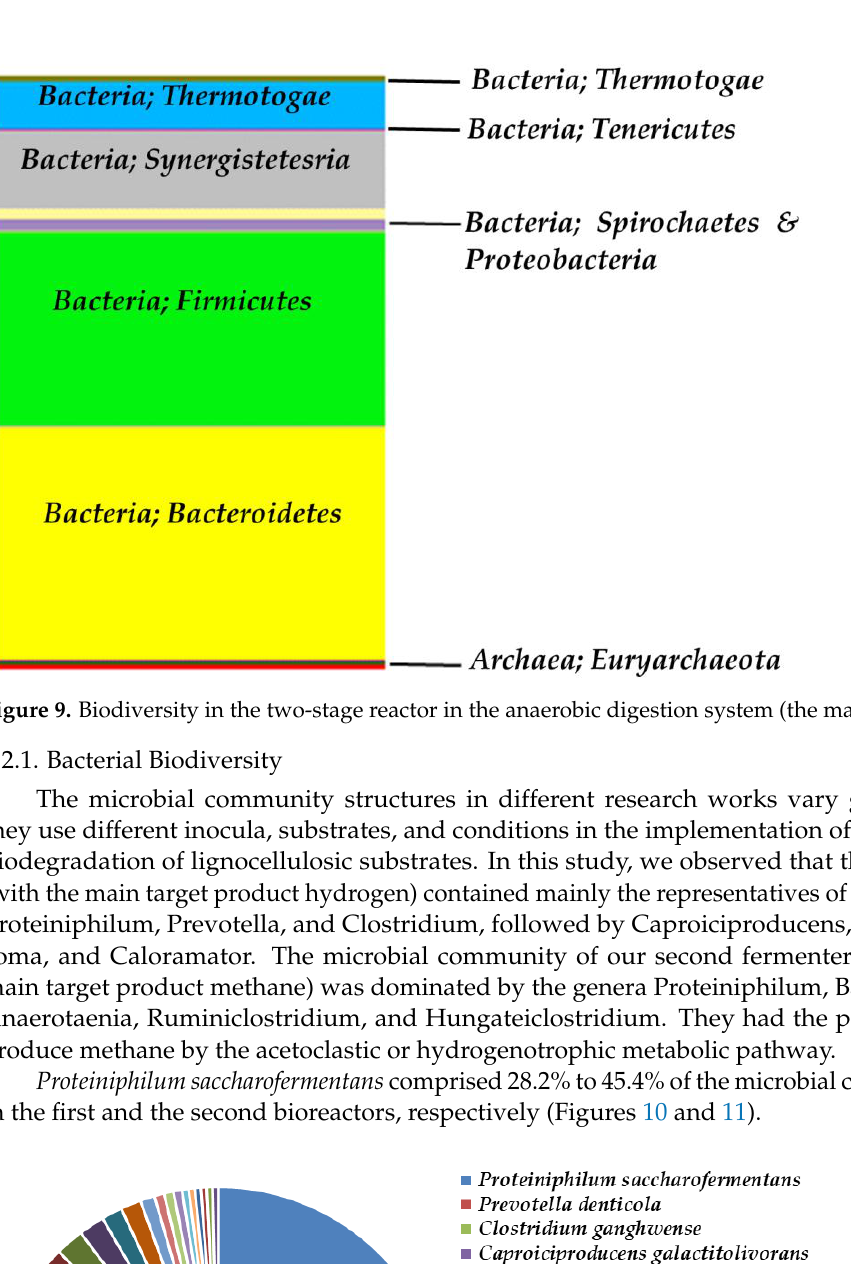
9 of 17 Figure 8. Gram-stained bacterial consortia under the microscopic view, (Leica, DMC4500 Digital